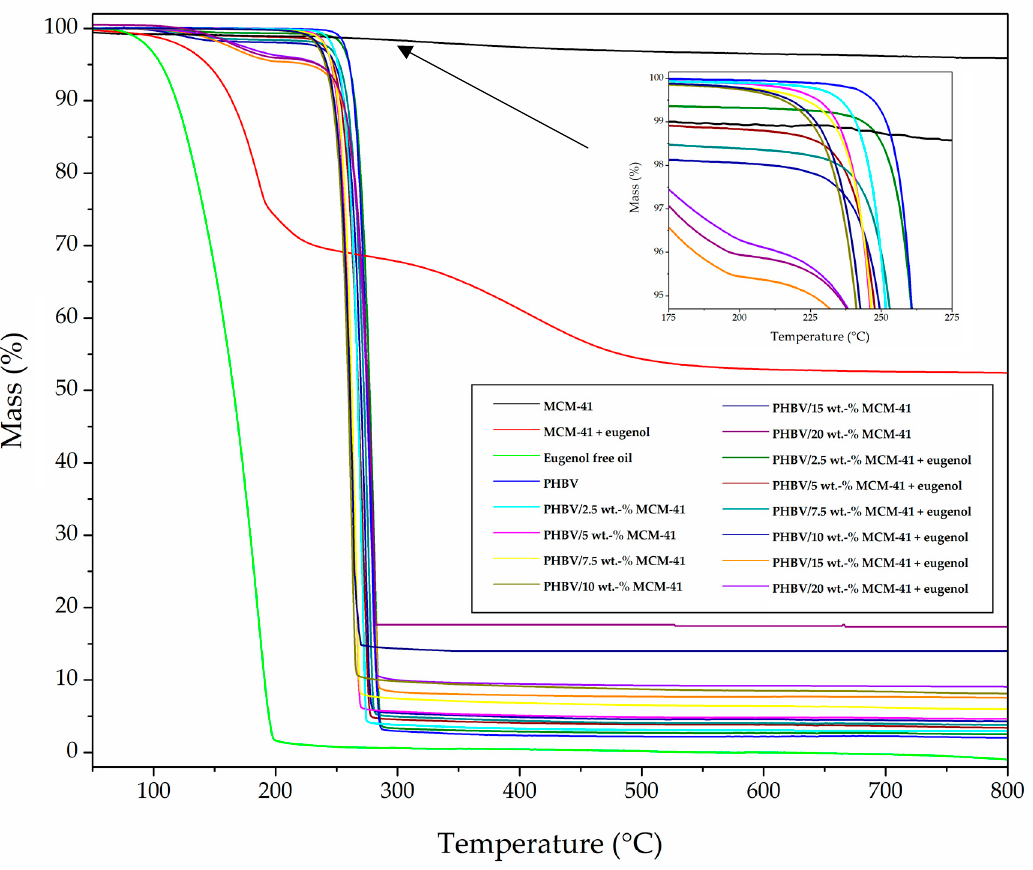
Figure 6. Thermogravimetric analysis (TGA) curves for Mobil Composition of Matter (MCM)-41, eugenol, MCM-41 with eugenol, poly(3-hydroxybutyrate- co -3-hydroxyvalerate) (PHBV), and PHBV/Mobil Composition of Matter (MCM)-41 without and with eugenol.